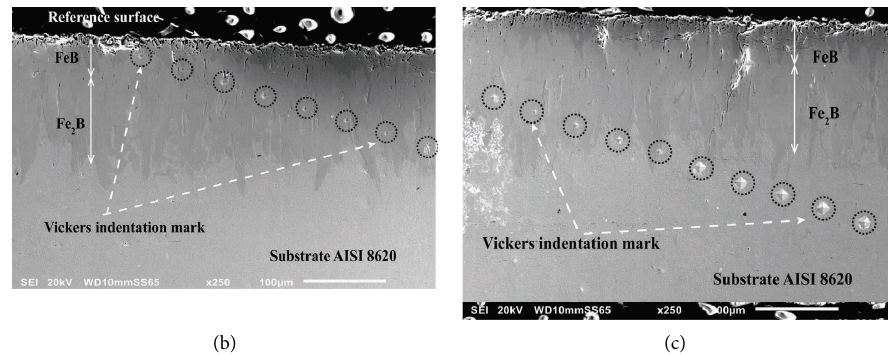
Figure 8: Te behavior of Vickers microhardness on surface AISI 8620 borided (a) profle on Vickers indentation in all condition. Vickers indentation mark on the surface AISI 8620 borided at 1223K for 6h (b) without uncharged hydrogen and (c) with charged